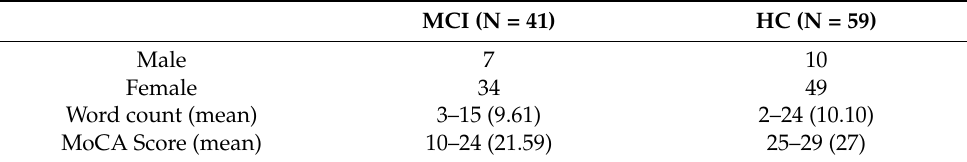
Figure 2. The PVF test in the MoCA application. ( A ) The application will read the PVF instructions “ please tell me as many words as possible that begin with the letter “ ก ” /k/ in one minute ” when staff press the speaker button. ( B ) Space for staff to take notes. ( C ) Red letters show the timer. PVF, phonemic verbal fluency; MoCA, Montreal cognitive assessment.